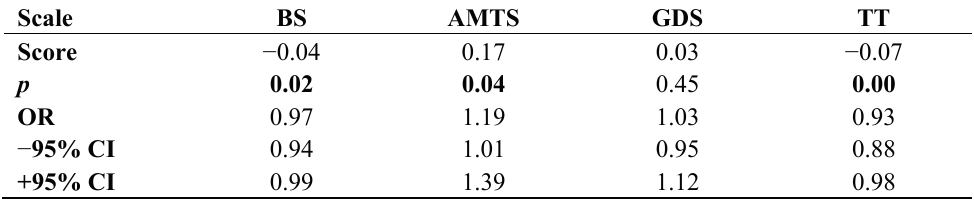
BS—Barthel Scale, AMTS—Abbreviated Mental Test Score, GDS—Geriatric Depression Scale, TT—Tinetti Test; N = 304 (NF ≤ 1 = 0, n = 167; F > 1 = 1, n = 137); χ 2 = 51.54, p =